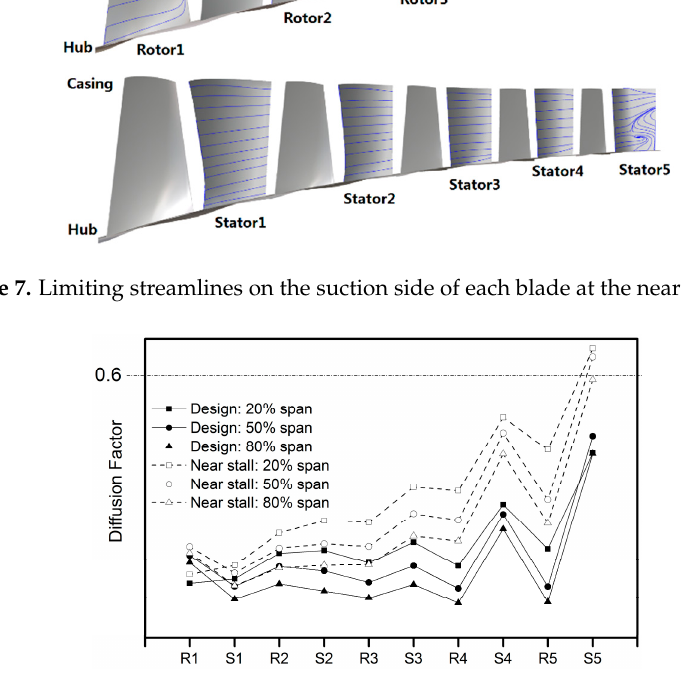
Figure 8. Streamwise diffusion factor distributions of each row.